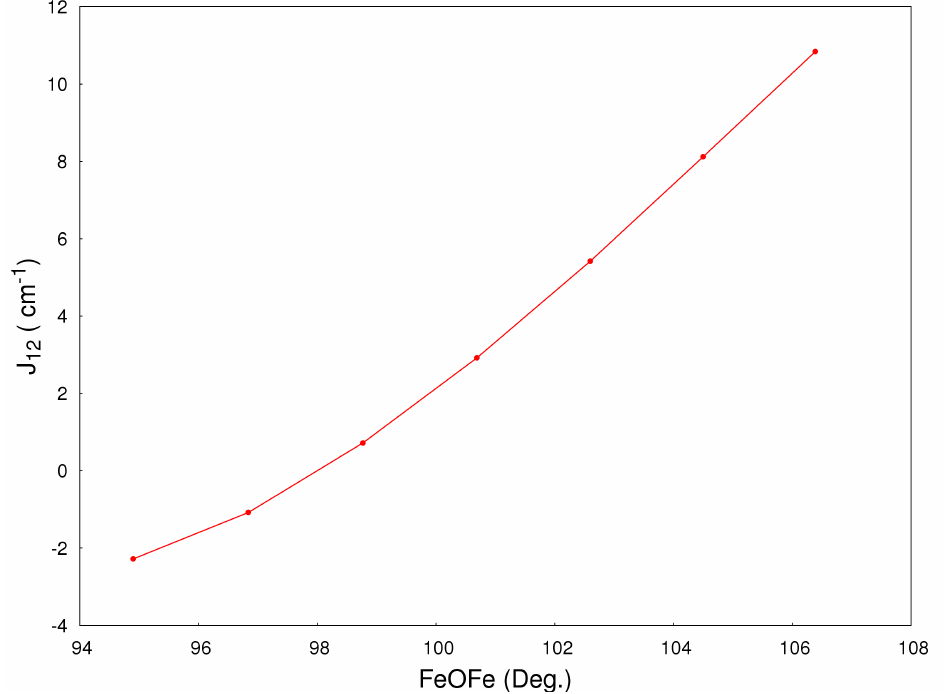
Figure 4. Magneto-structural correlation plot for J 12 (cm − 1 ) as function of the FeOFe angle (Deg.). In contrast, D 12 values do not change smoothly with the angle FeOFe and span a relatively large amplitude of values for the selected configurations (Figure 5). Interestingly, the trend presents